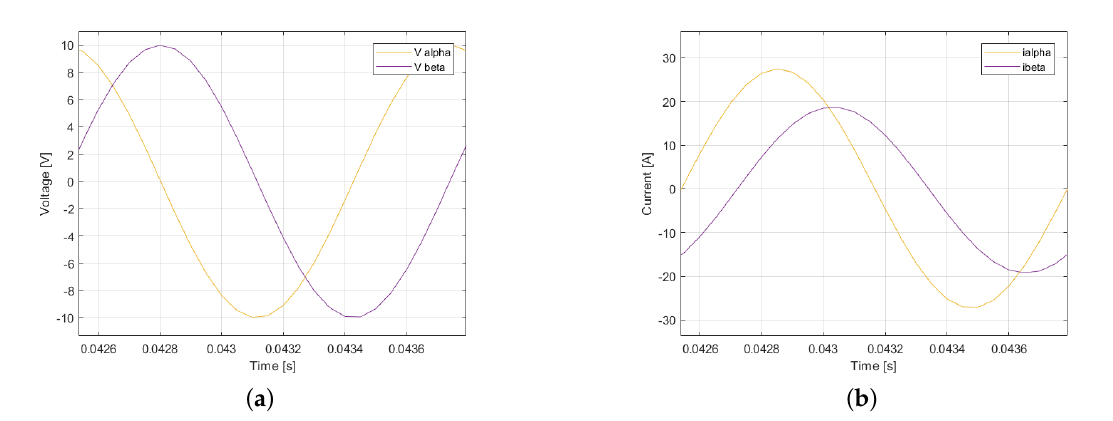
Figure 7. Saliency-based estimator simulation. ( a ) Injected voltages. ( b ) Phase-shifted currents.